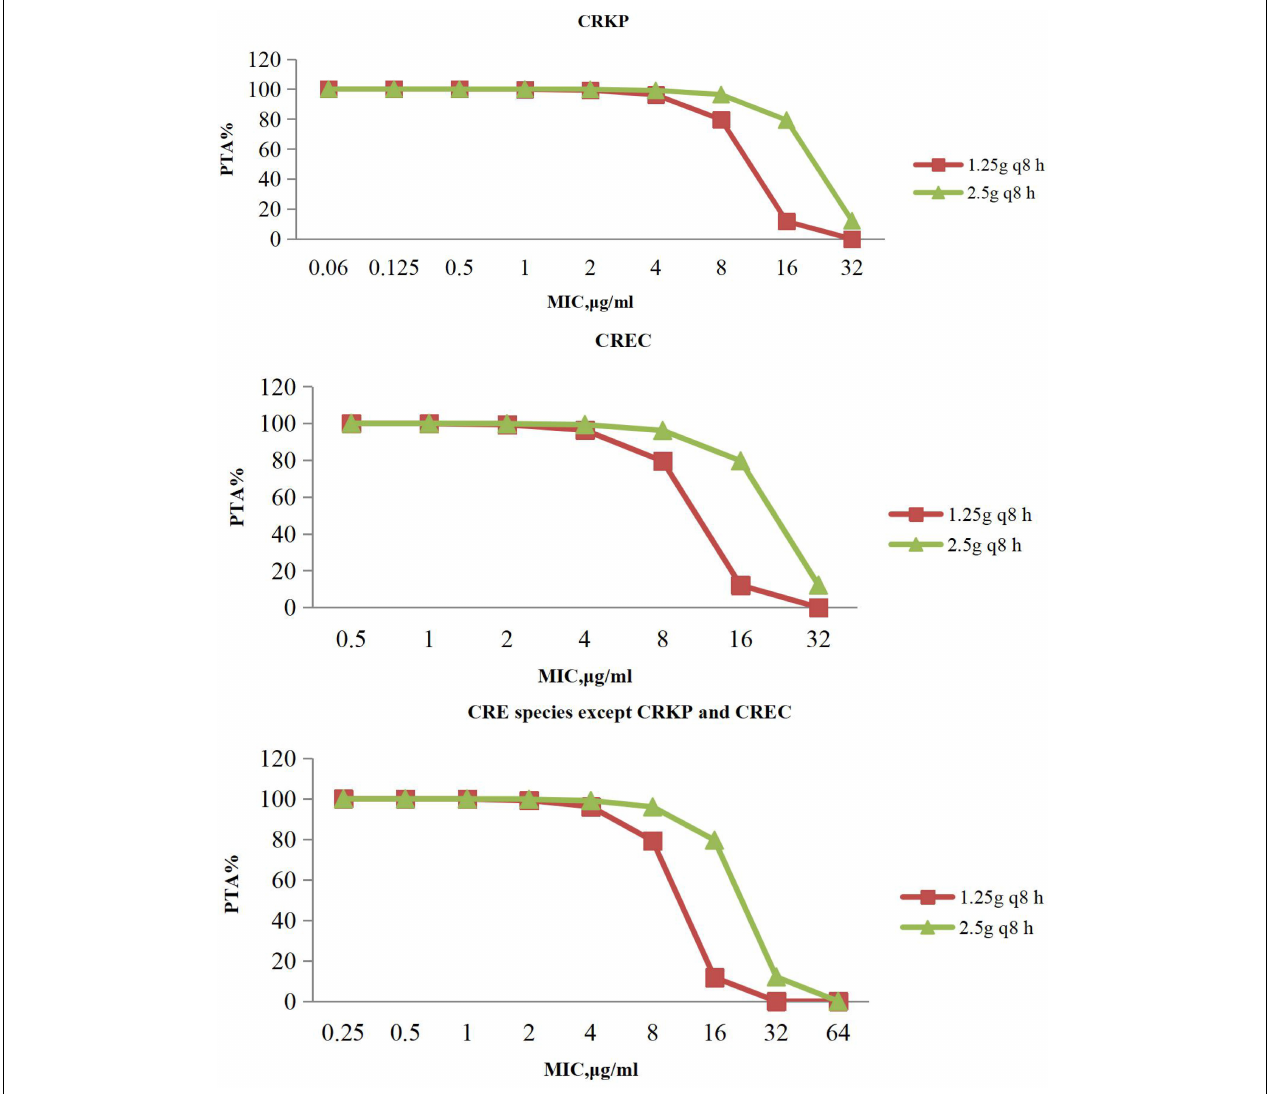
FIGURE 3 | PTA against CRE at MICs from 0.06 to 64 mg/L for ceftazidime/avibactam. PTA, probability target attainment; MIC, minimum inhibitory concentration; CRE, carbapenem-resistant Enterobacterales; CRKP, carbapenem-resistant Klebsiella pneumoniae ; CREC, carbapenem-resistant Escherichia